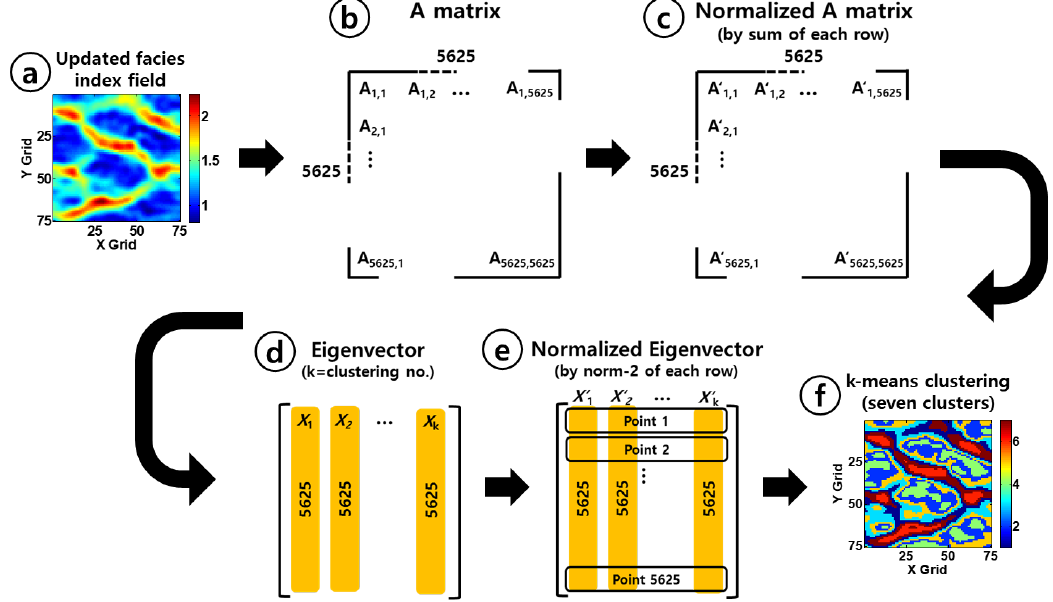
Figure 4. SCA application for clustering of an updated facies index field (7 clusters). Table 1. Arrangement sequence of clusters based on average index values of each cluster.